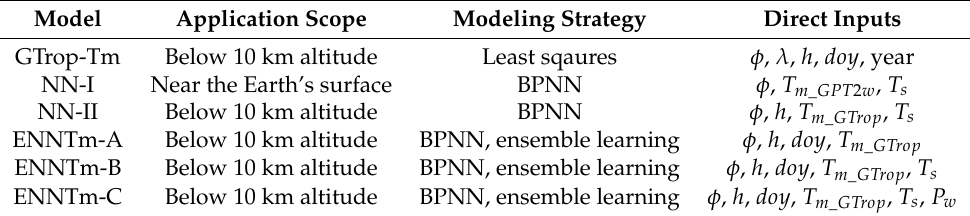
Table 2. The features and operation conditions of different competing